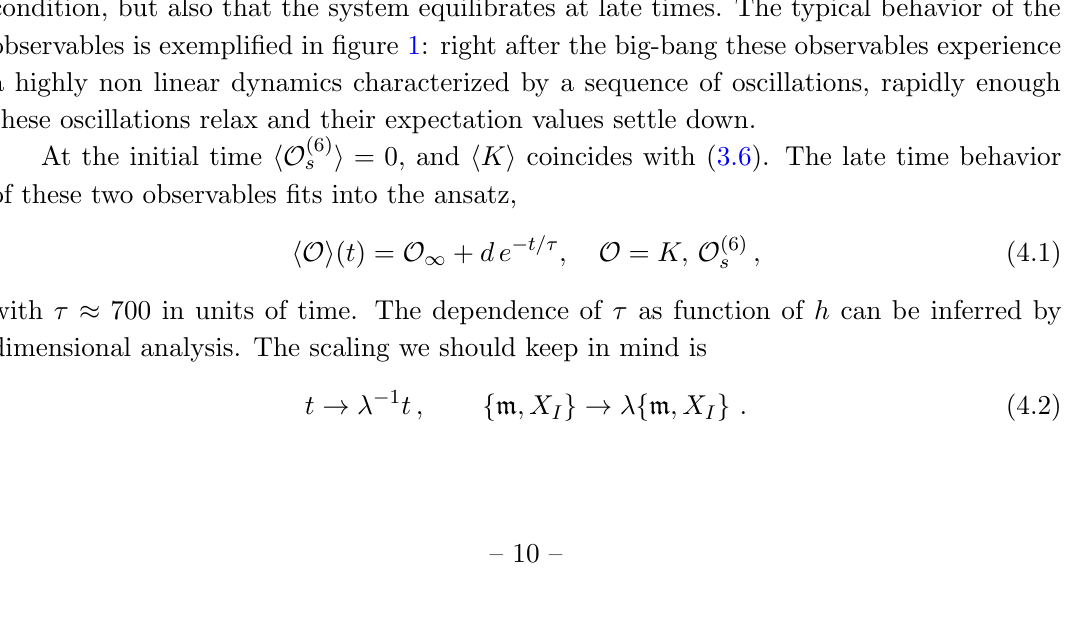
, K , and N 1 , for h = 0 : 3 h and d < 0 for K h